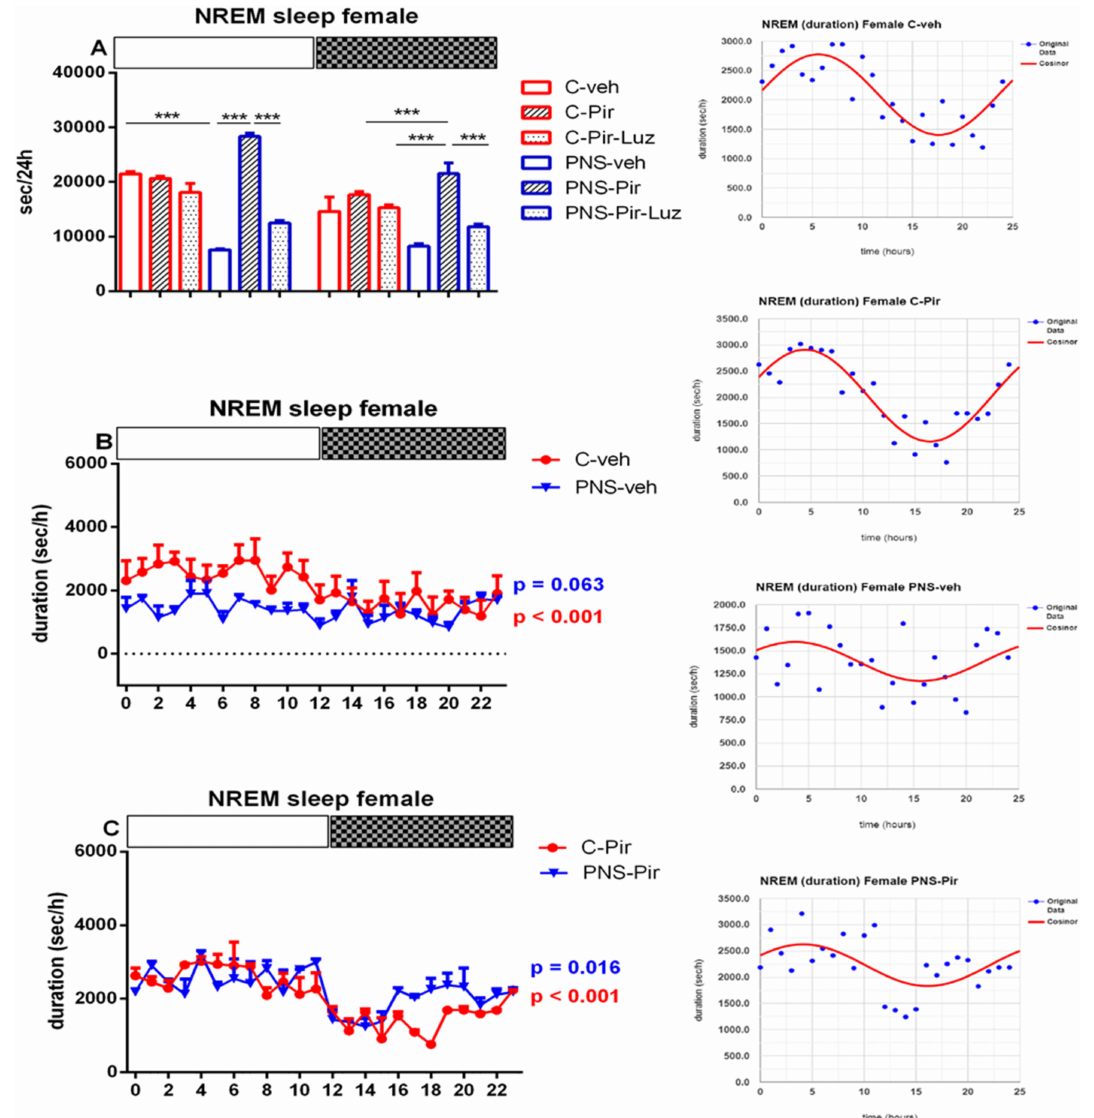
Figure 8. Diurnal rhythm of NREM duration (sec/h) in female rats during the Light and the Dark phase, indicated by open and black rectangles above the figure, over a 24-h recording for C-veh, C-Pir, C-Pir-Luz, PNS-veh, PNS-Pir and PNS-Pir-Luz group ( A ). Circadian distribution of NREM sleep events (duration, sec/h) for C-veh and PNS-veh groups ( B ) and C-Pir and PNS-Pir group ( C ) over a 24-h recording. Original and cosinor data are shown in inset on the right. *** p < 0.001 vs. C-veh, PNS-veh or PNS-Pir group,